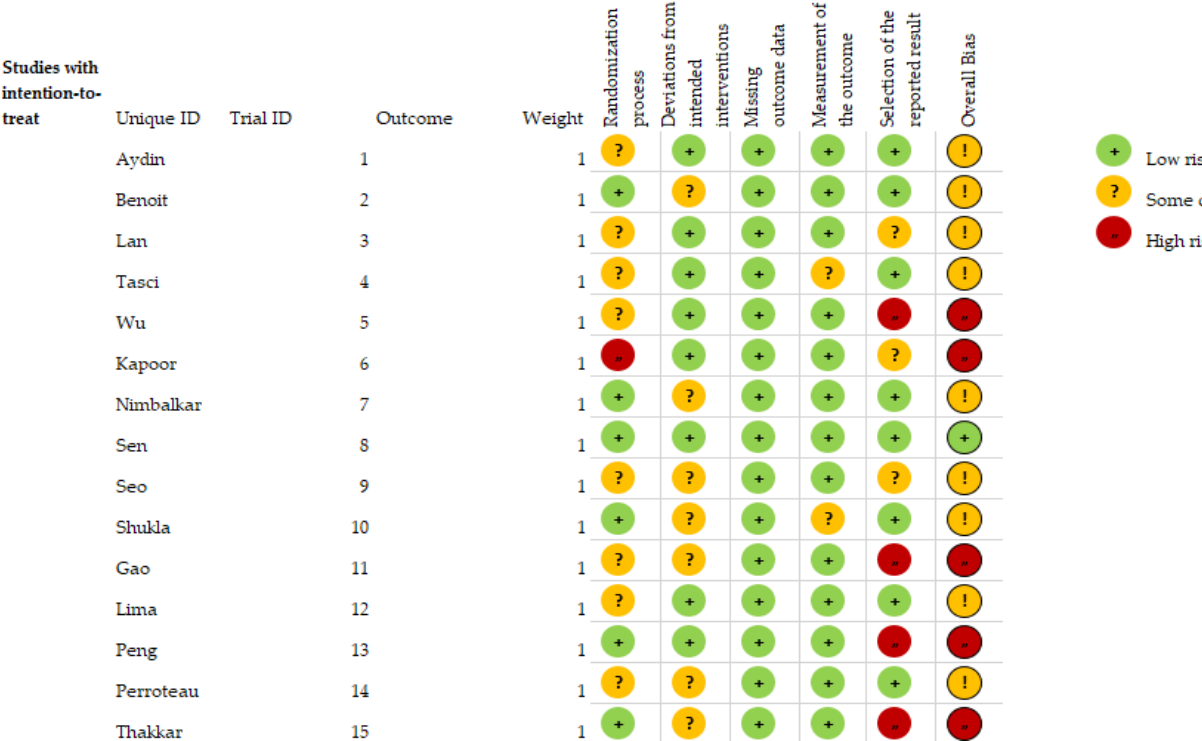
Figure 3. Risk of bias assessment for each included study.